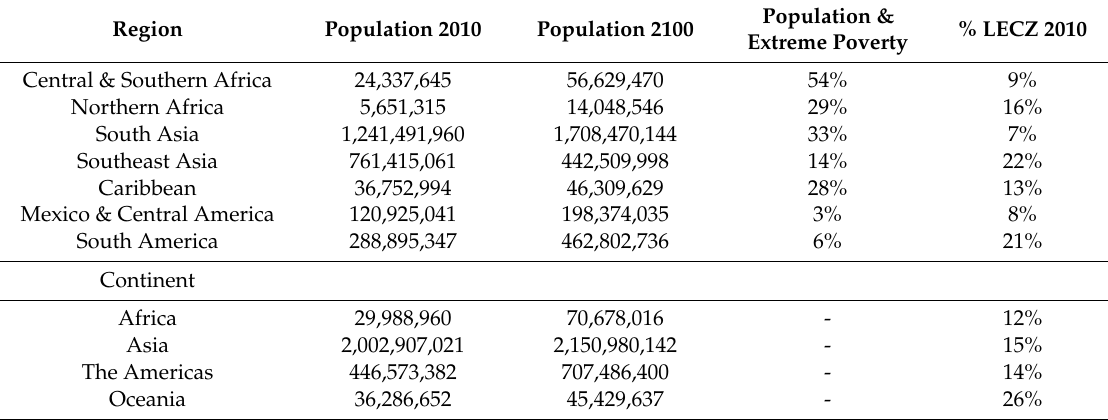
Table 4. Demographic trends and population living in low-elevation areas in coastal zones